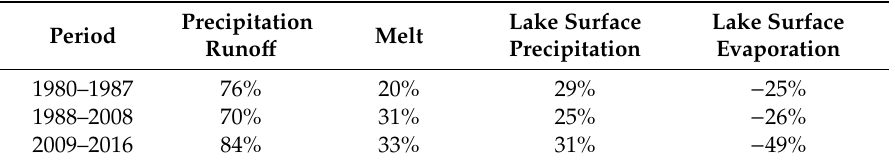
Table 2. Attribution analysis results in three